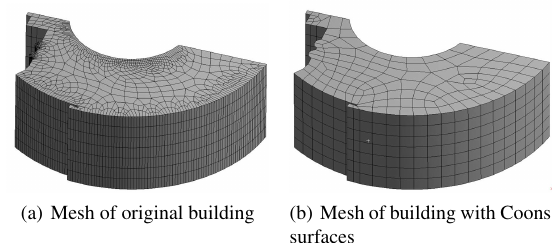
Figure 16. Comparison of meshes of (a) original building with arches represented by thin polygons and (b) building with arches replaced by Coons